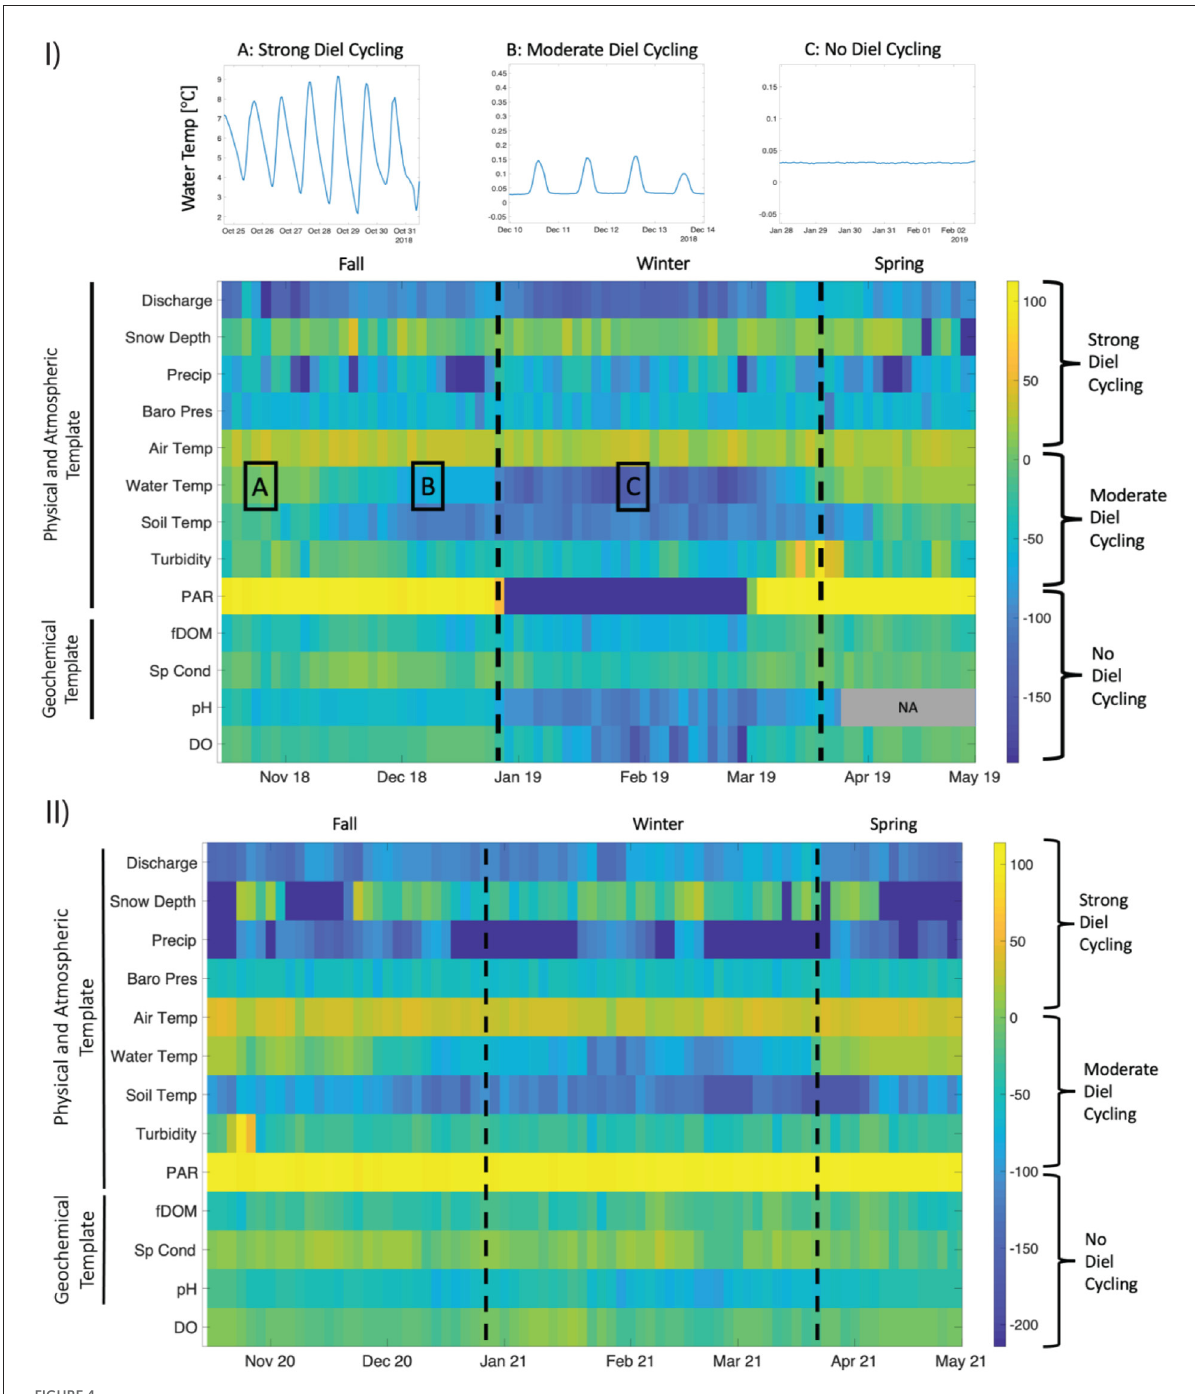
FIGURE4 Heatmap of spectral power at 24-h periodicity for (I) El Niño 2018–2019 and (II) La Niña 2020–2021 years organized by physical and atmospheric, and geochemical templates. For reference, we highlight examples of A: strong, B: moderate and C: no diel cycling for water temperature. Dashed vertical lines delineate fall, winter, and spring seasons. Missing pH values are shown as